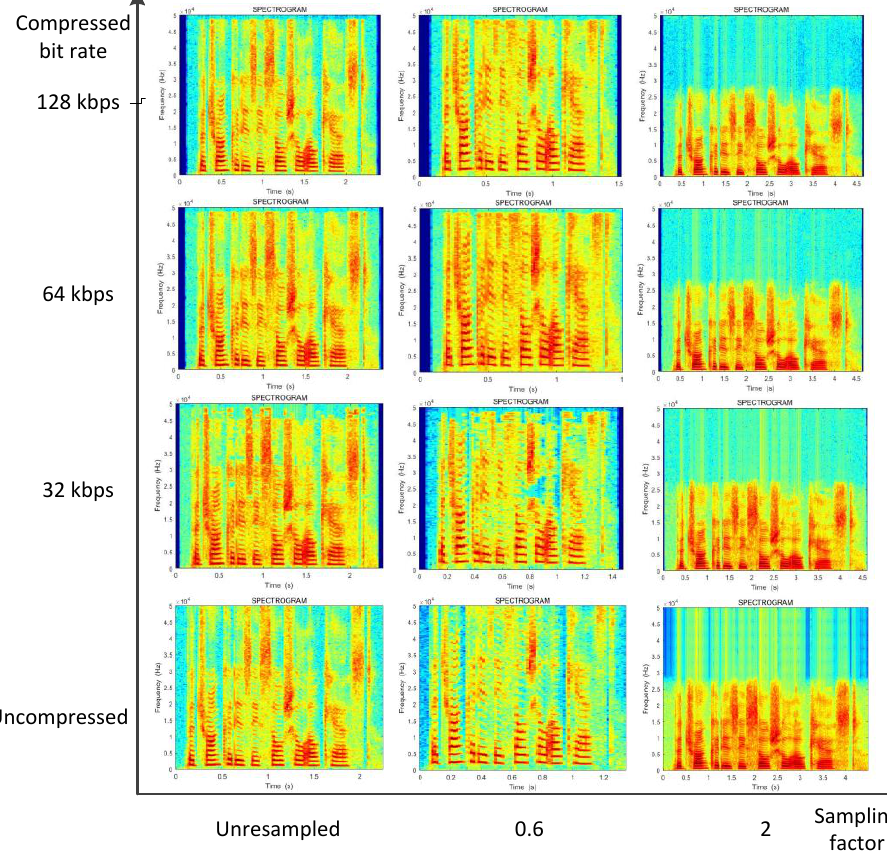
Figure 2. Spectrogram distribution in different situations .